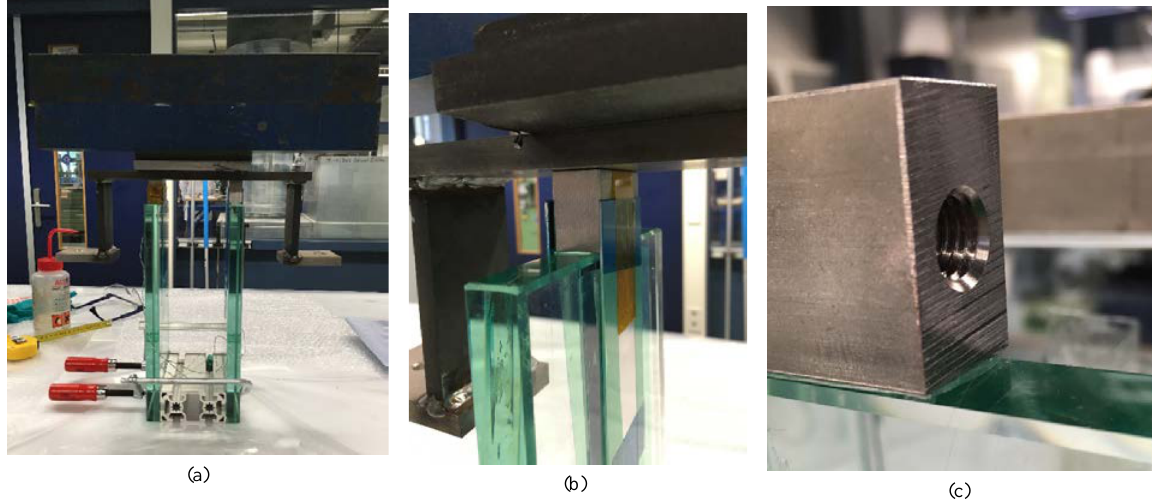
Fig. 5 Sample fabrication: (a) arrangement for the application of pressure to the connectors, (b) aluminium plates for stability and alignment of the connector, (c) close view to the connection after lamination